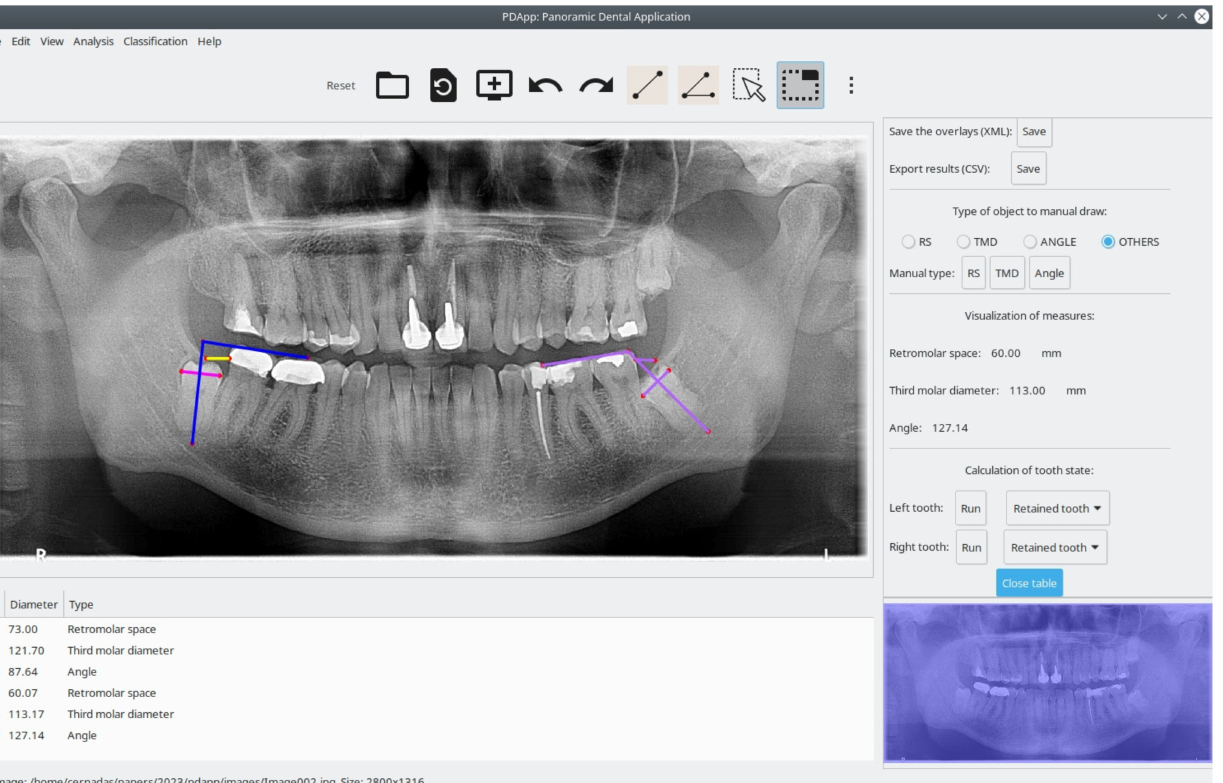
Figure 3. Visual example showing two third molars analyzed, in which the PDApp prediction for both cases is correct as a retained tooth. The pink line represents third molar diameter, the yellow line represents retromolar space, and blue lines represent the angle of eruption. The lateral panel shows the measures for the left third molar (violet lines on the image represents the measurements